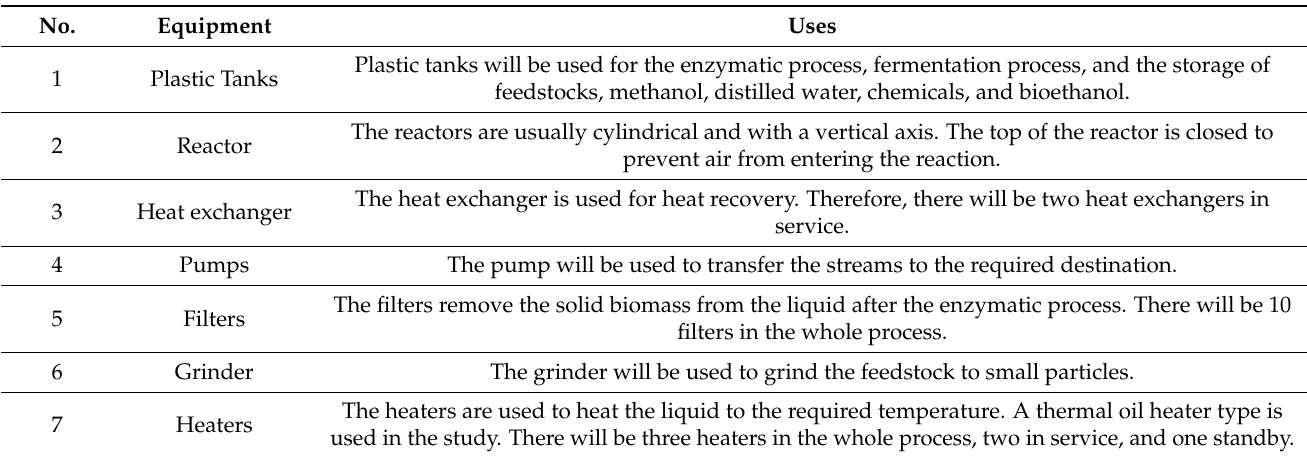
Table 3. Equipment